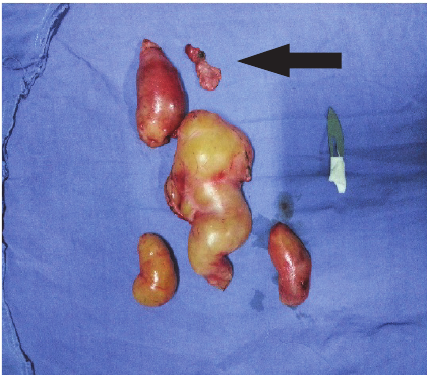
Figure7:Theentireresectedspecimenswithonelymphnode(black